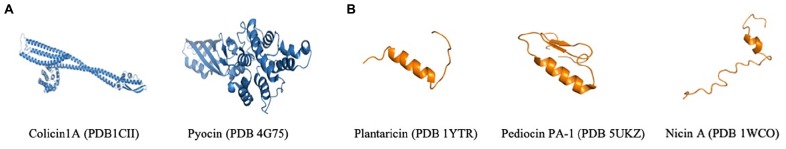
An overview of different structures of bacteriocins, proteins (A) and peptides (B) with dual anticancer and antimicrobial activity. All of these structures are available on the PDB.